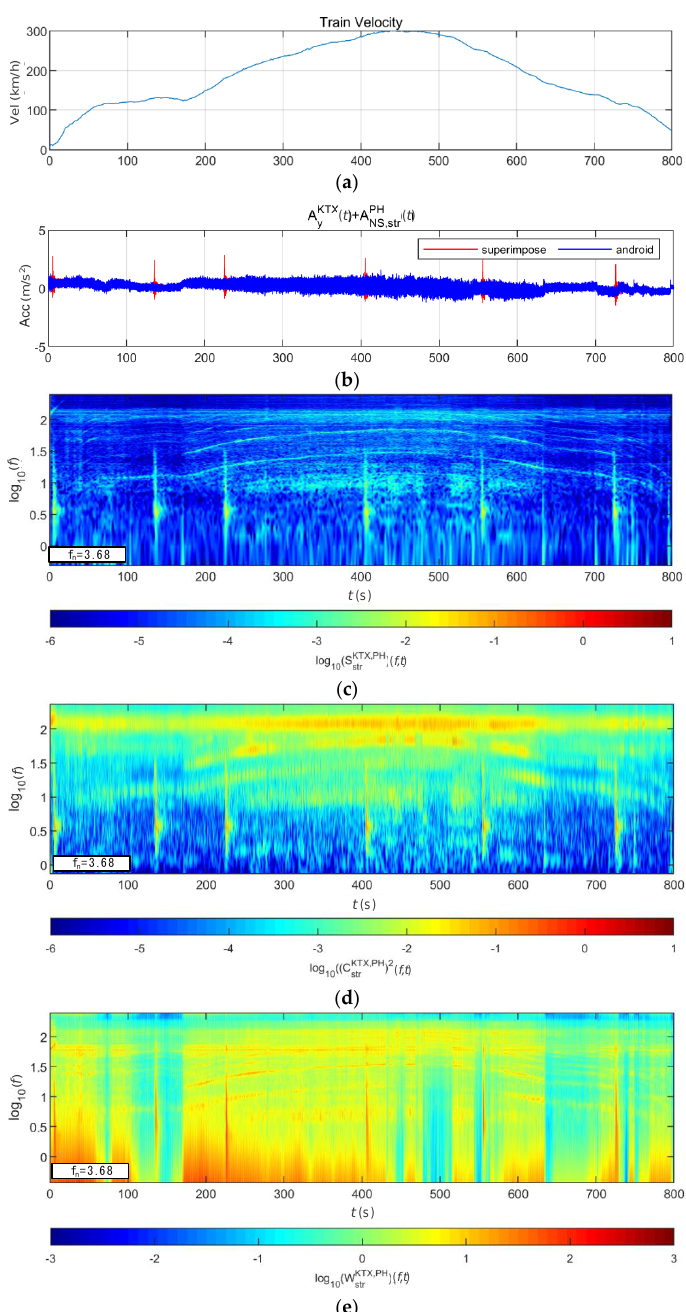
Figure 36. Combination of train data with BR3 bridge-response data from the Pohang earthquake (scaled to 1000-year return period): ( a ) velocity; ( b ) lateral acceleration time series; ( c ) STFT; ( d ) WT; ( e ) WVD.